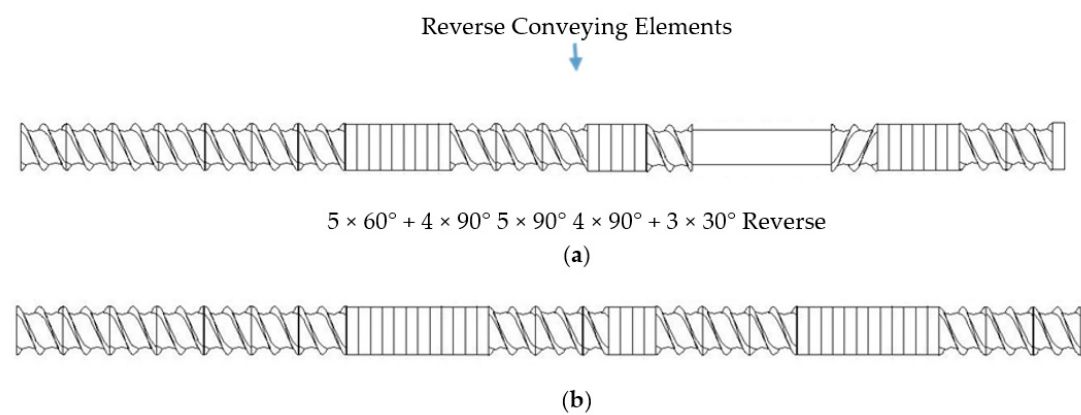
Figure 2. Schematics of the ultrasonic ( a ) and mixing ( b ) screws. The flow direction is from left to right.